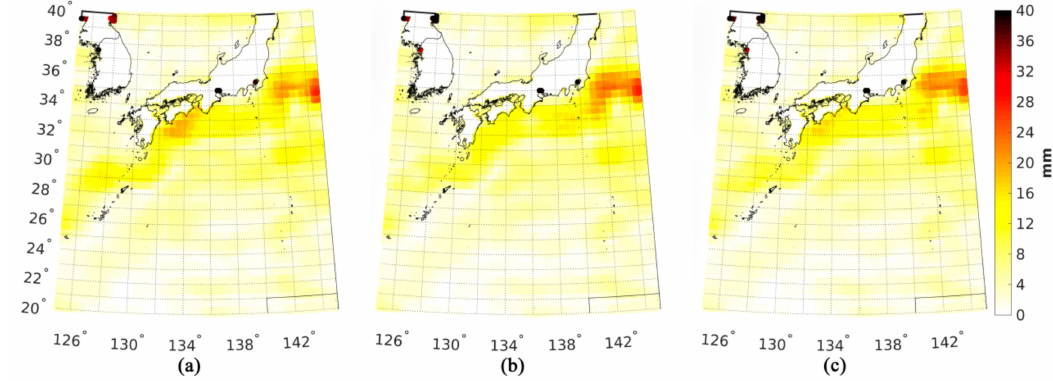
Figure 8. The estimated errors the MDT solutions ( a ) DTU18DIRR4-MDT; ( b ) DTU18DIRR5-MDT; ( c )